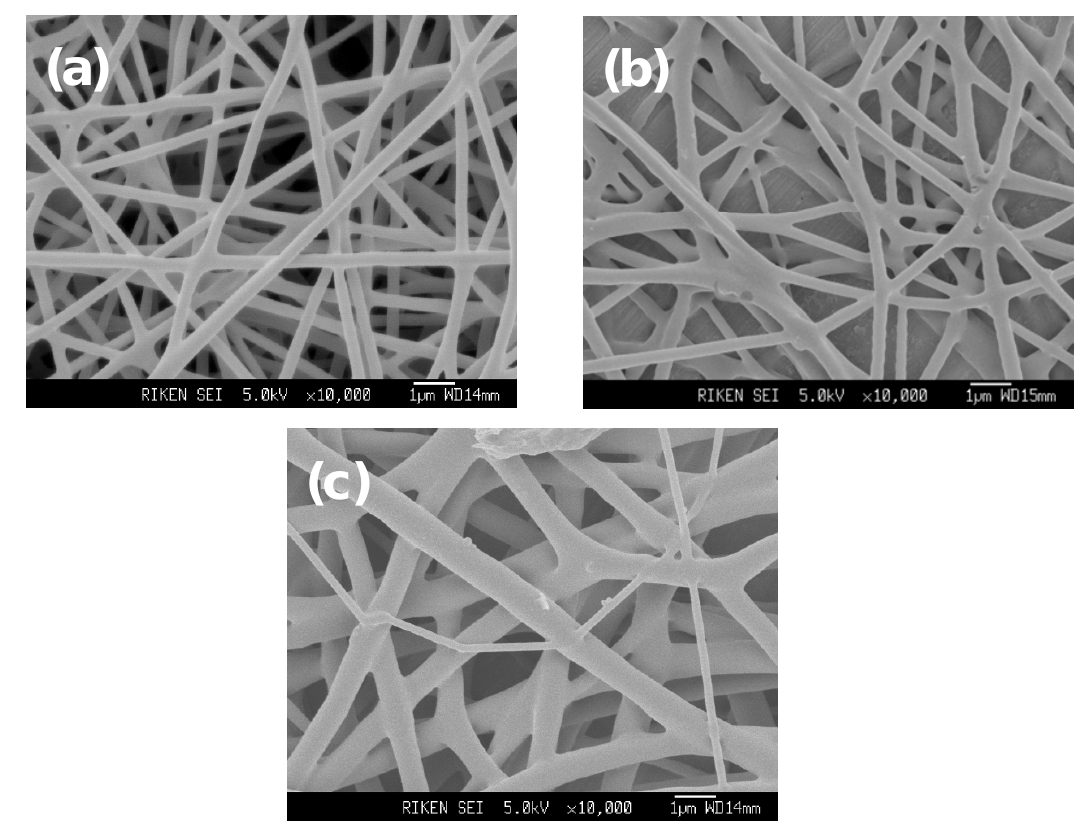
Figure 2. SEM images of P(3HB) nanofiber electrospun from HFIP solution with a